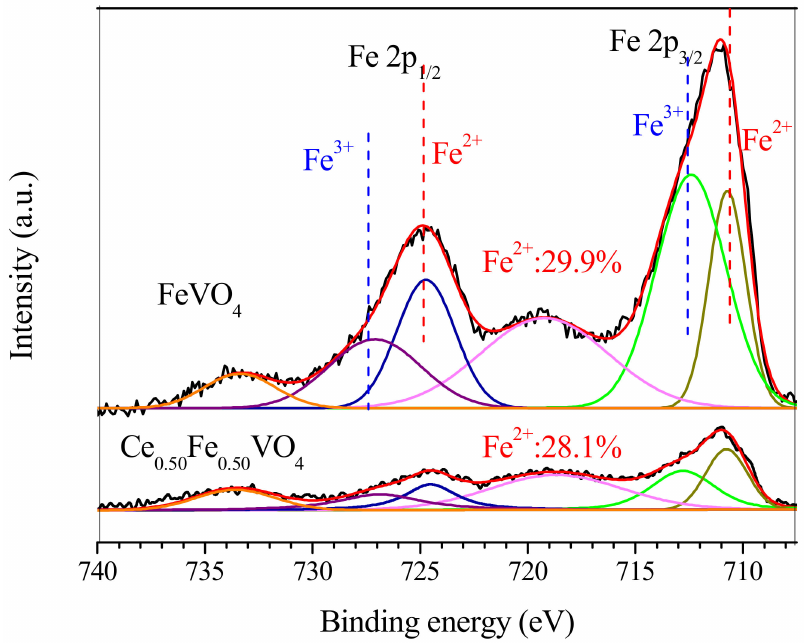
Figure 7. Fe 2p XPS spectra of CeVO 4 and Ce 0.50 Fe 0.50 VO 4